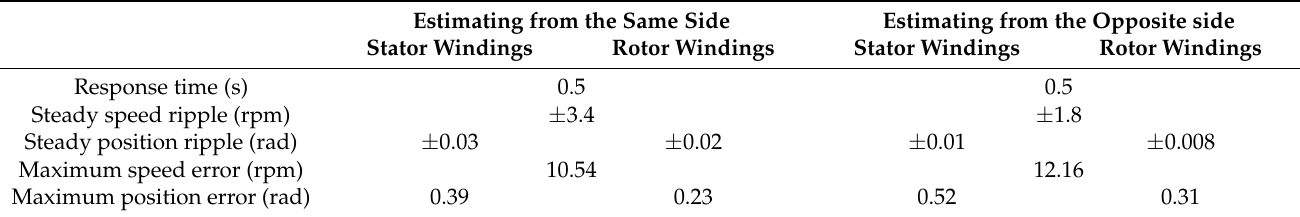
Figure 12. The startup results of estimating from the opposite side. ( a ) Speed. ( b ) Stator position. ( c ) Rotor position. Table 2. Comparison of two estimating